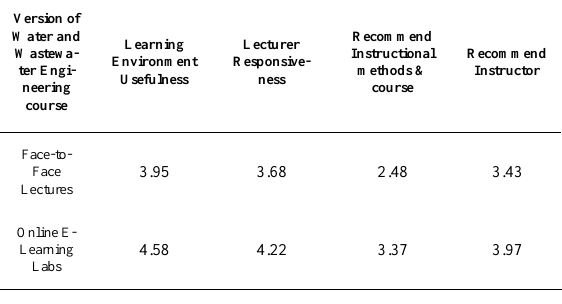
TABLE I. A VERAGE STUDENT RATINGS GIVEN TO THE COURSE COMPONENTS COMPARING FACE - TO - FACE LECTURES WITH THE E - LEARNING ONLINE ENVIRONMENT (S AMPLE NUMBER N = 35, ON A SCALE OF 1-5, WITH 5 BEING THE HIGHEST AND 1 THE LOWEST ) Version of Water and